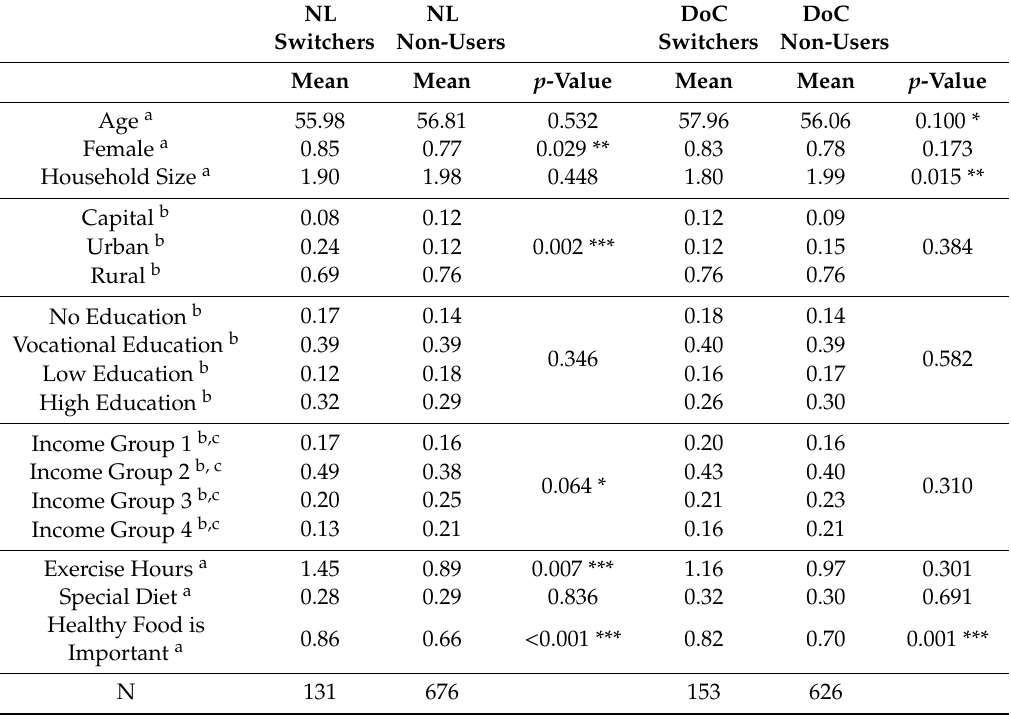
Table 4. Summary statistics of NL / DoC switchers and non-users in